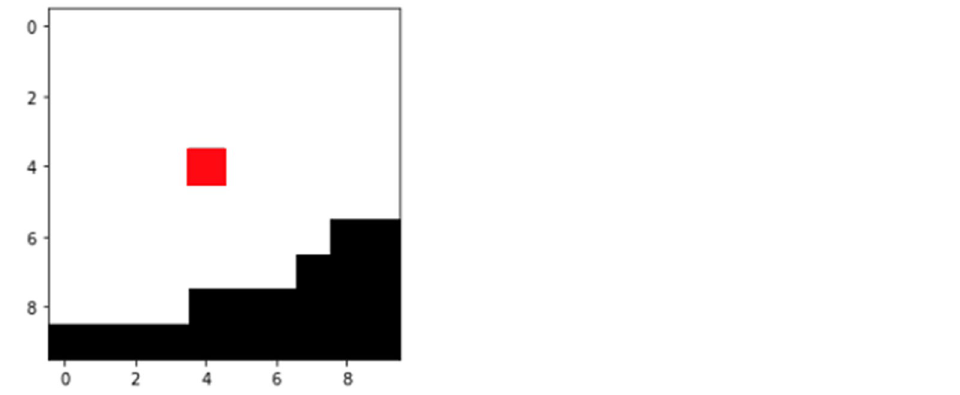
Figure 6. Position of the inlet path based on the center of mass of the void surface.